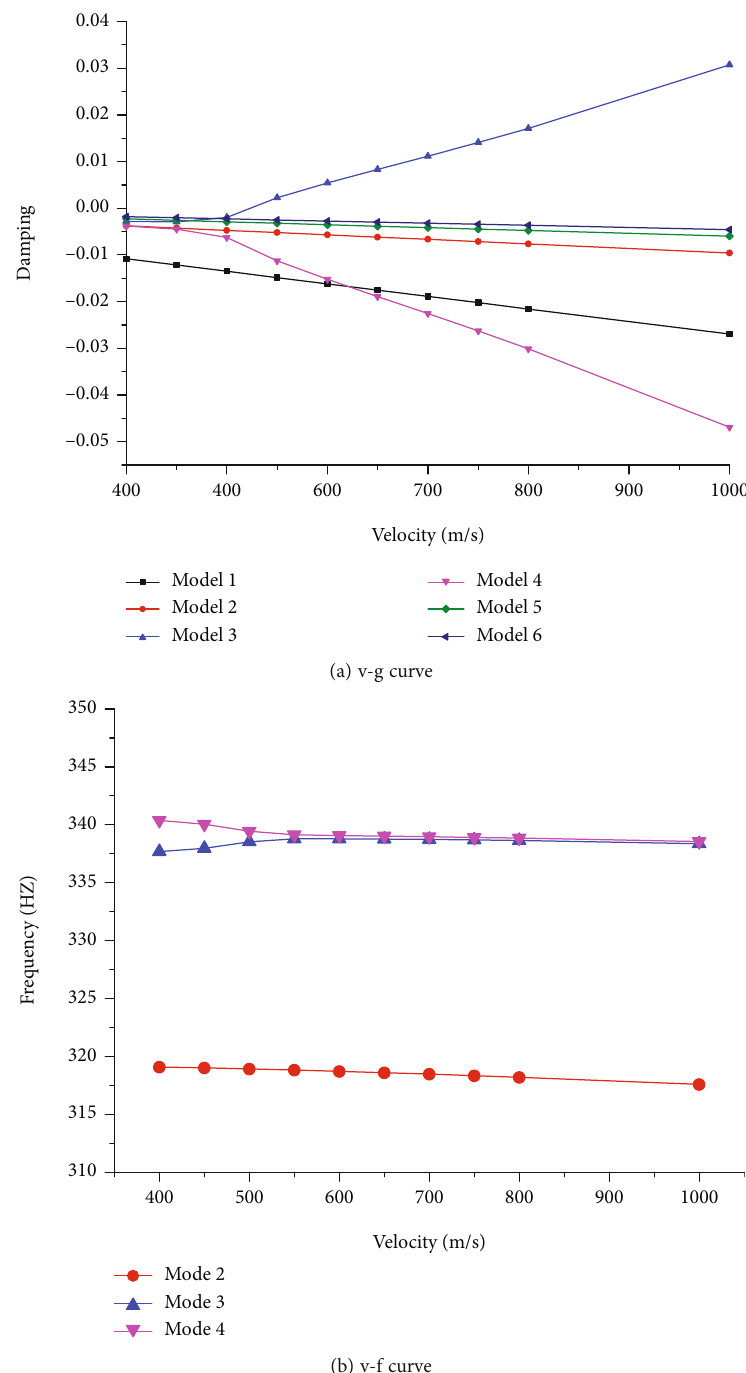
Figure 8: V-g and v-f curves for point